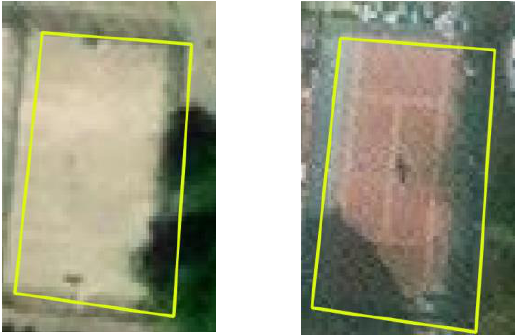
Figure 13. One example from False positive result. Yellow: Vector dataset. The building height is 3 meters.